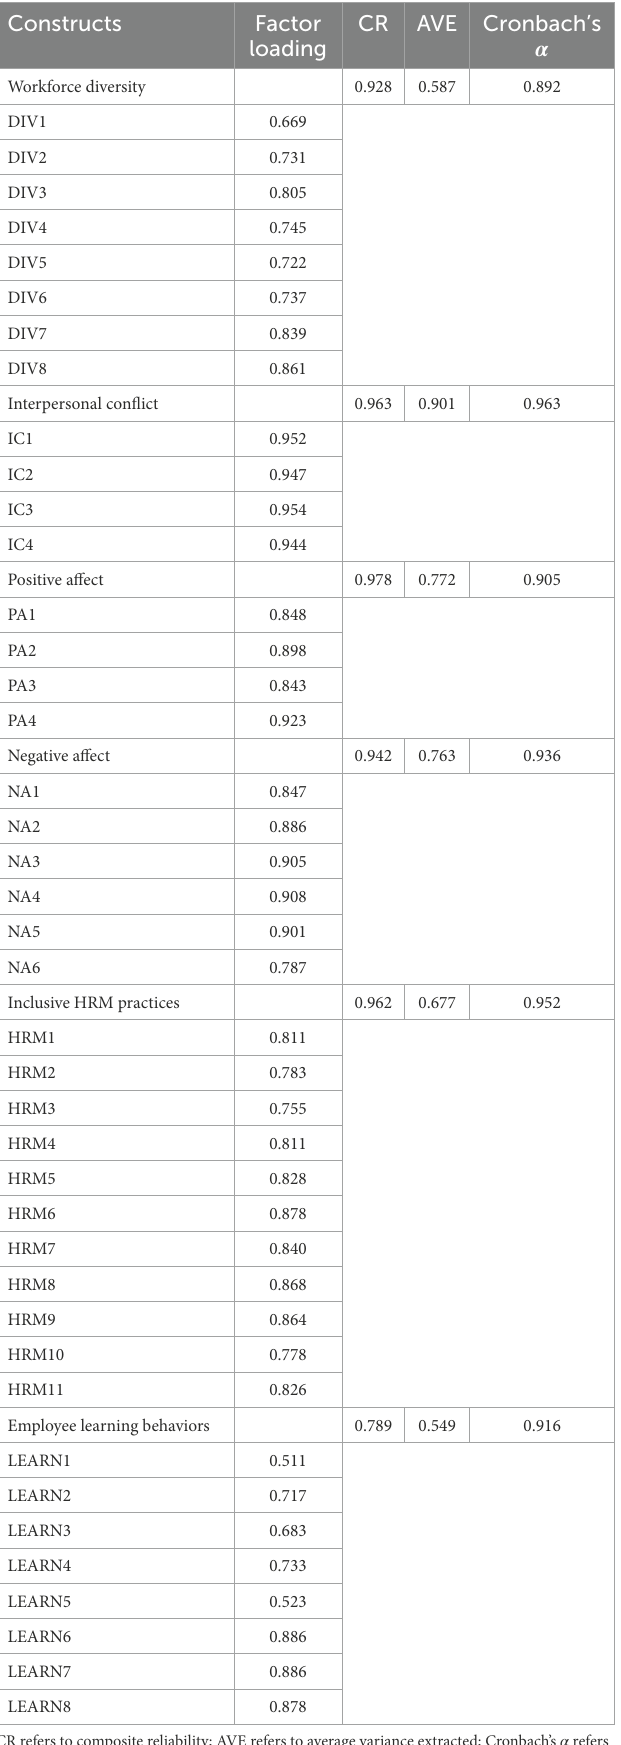
TABLE 4 Factor loadings, CR, and AVE for studied variables.